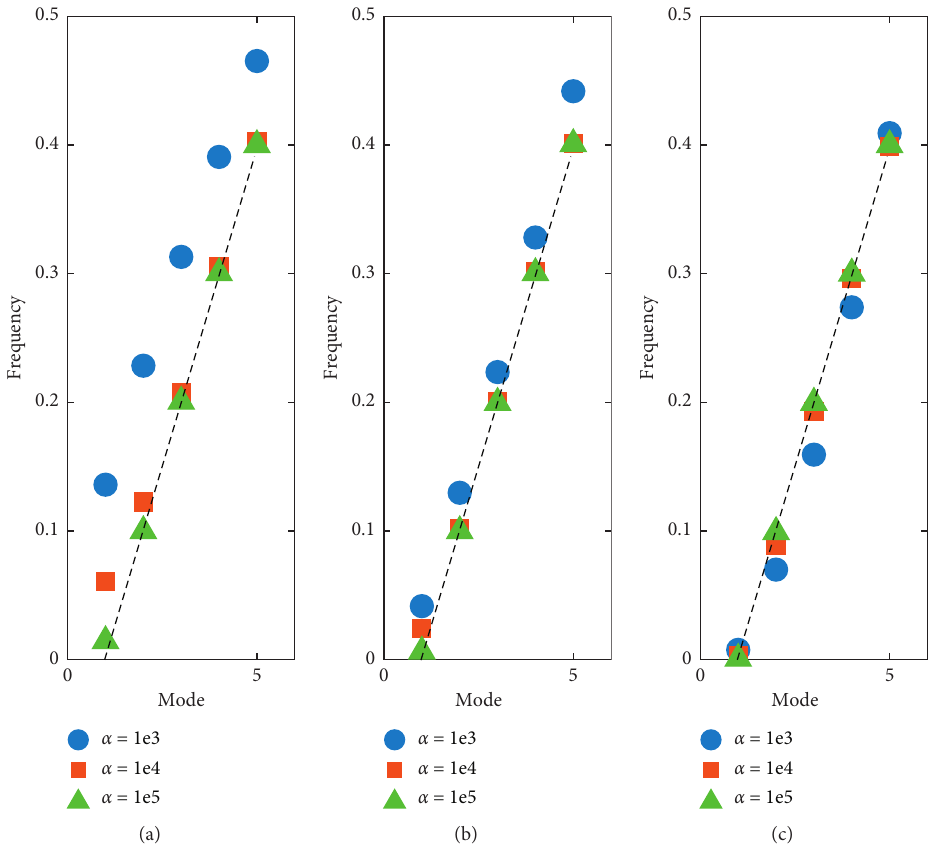
Figure 3: The averaged center frequencies ω n 􏼈 􏼉 of each mode u k , in the case of three typical Hurst exponents: (a) H k H � 0.8. The dashed lines denote the uniformly initialized center frequencies plotted as a function of modal